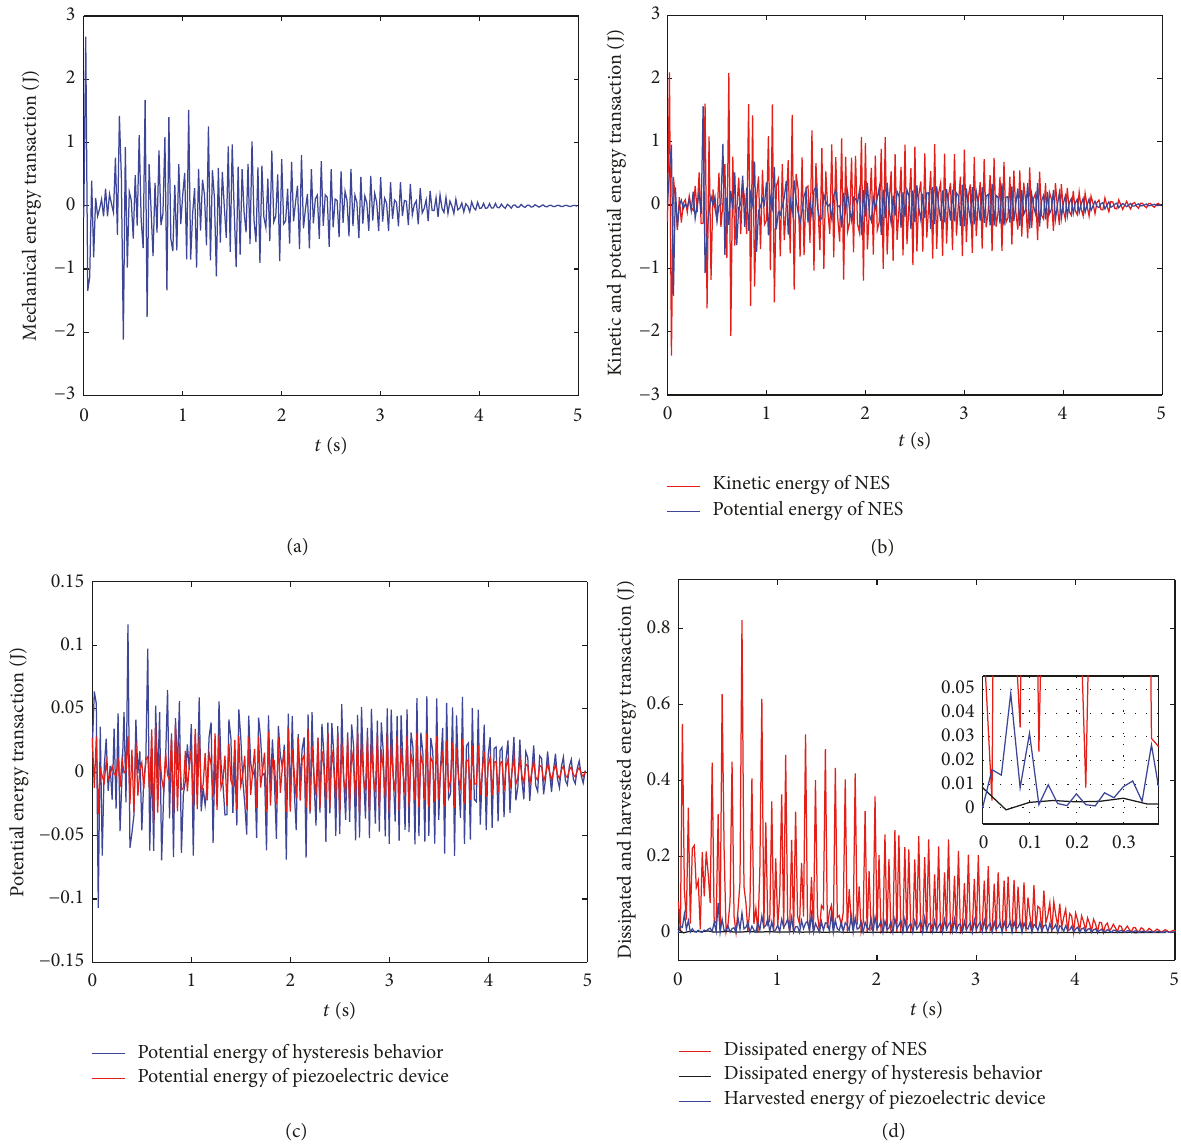
Figure 7: Configuration 1: (a) mechanical energy transaction in the NES-piezoelectricity system; (b) kinetic and potential energy transaction of NES; (c) potential energy transaction of hysteresis behavior and piezoelectric device; (d) dissipated and harvested energy transaction in the NES-piezoelectricity